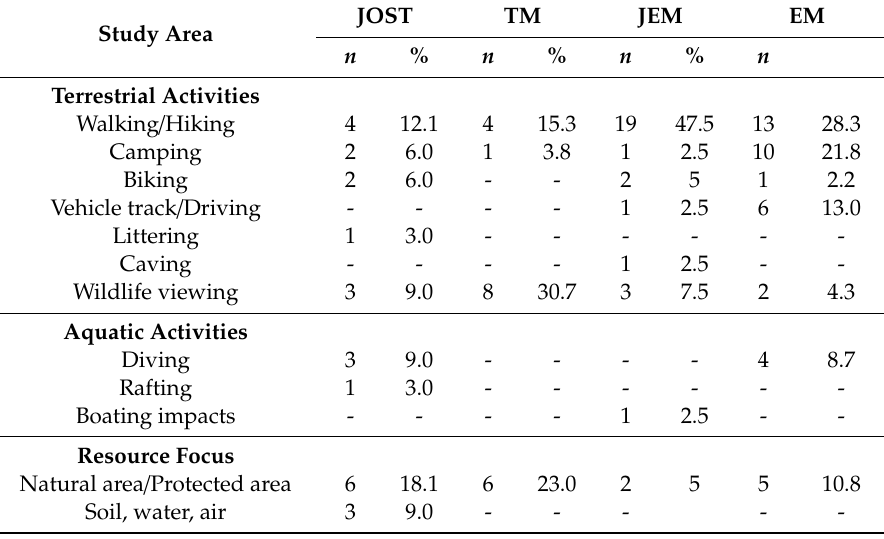
Table 4. Subject focus of recreational ecology papers (JOST, TM, JEM, EM,